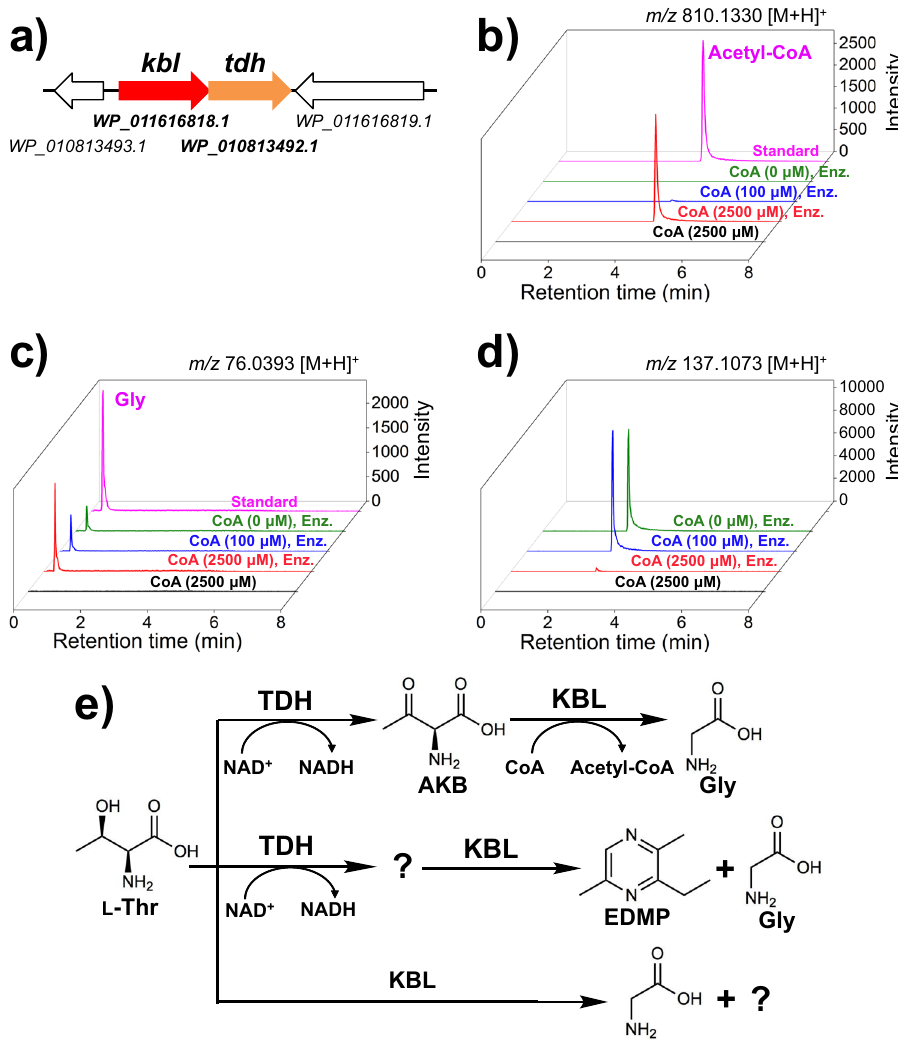
Fig. 1 Characterization of the tdh and kbl operon. a Operon formed by the tdh and kbl genes in Cupriavidus necator . Genes coding tdh and kbl are colored by orange and red, respectively. LC-HRMS analysis of acetyl-CoA ( b ), Gly ( c ), and EDMP ( d ). The following compounds and enzymes are contained in the reaction system: L-Thr, NAD + , and CoA (2500 μ M) (black line); L-Thr, NAD + , CoA (2500 μ M), CnTDH, and CnKBL (red line); L-Thr, NAD + , CoA (100 μ M), CnTDH, and CnKBL (blue line); L-Thr, NAD + , CnTDH, and CnKBL (green line); and standard (magenta line). Enz. means that CnTDH and CnKBL